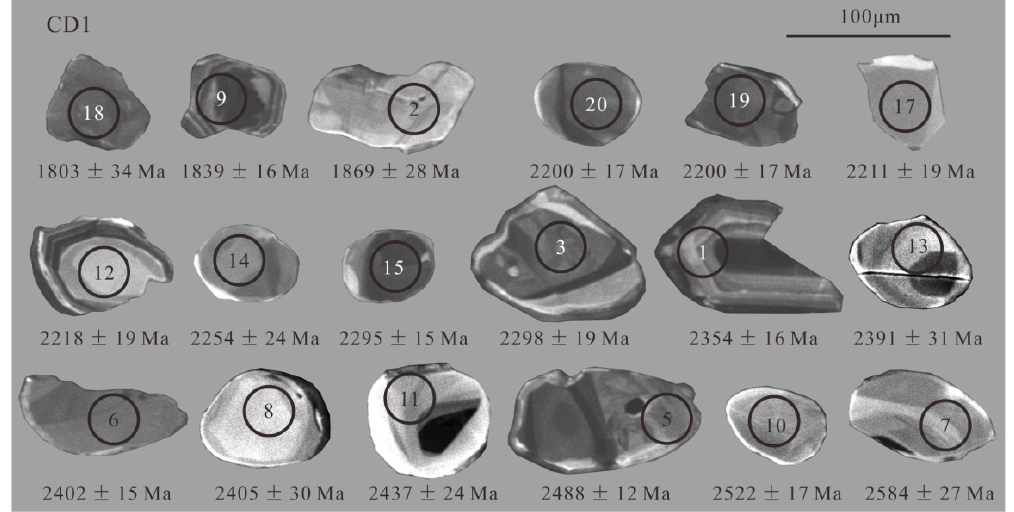
Figure 3. Zircon CL images of the Paleoproterozoic Gaositai hornblendite. Numbers in circles are analysis numbers.